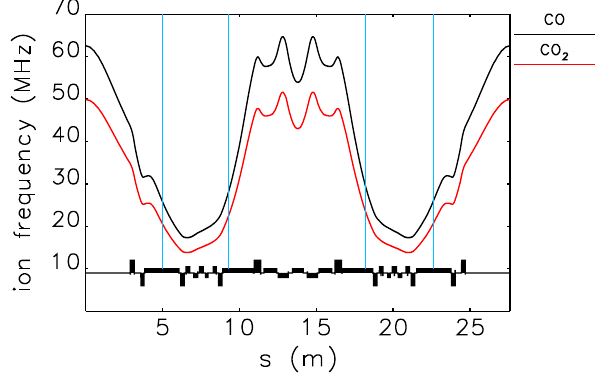
FIG. 4. Pressure profiles for one sector of the APS-U storage ring, calculated by M ol F low+ , for 1000 Ah beam scrubbing and 200 mA beam current. The vertical lines indicate the regions where CO 2 ions are